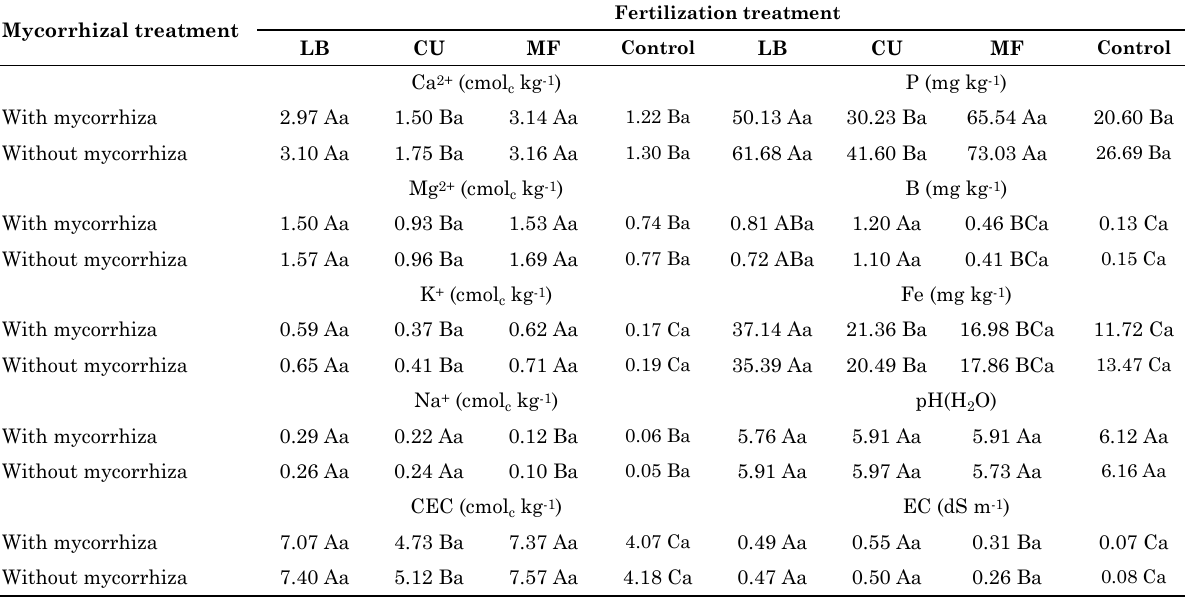
Table 2. Exchangeable cations, soil cation exchange capacity (CEC), P, B, Fe, pH in water, and soil electrical conductivity (EC) as a function of the treatments studied Mycorrhizal